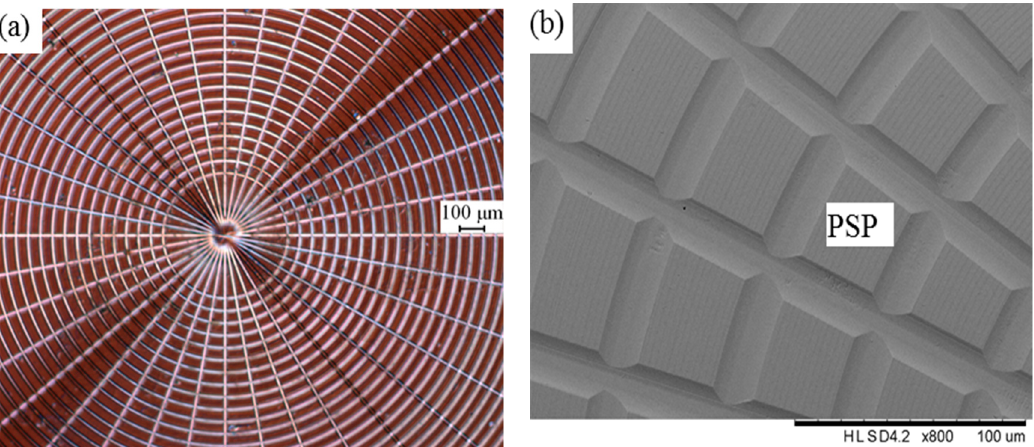
Figure 8. Polar microstructure measured by ( a ) Pearl Centering Microscope ( b ) Hitachi Electron Microscope TM3000.